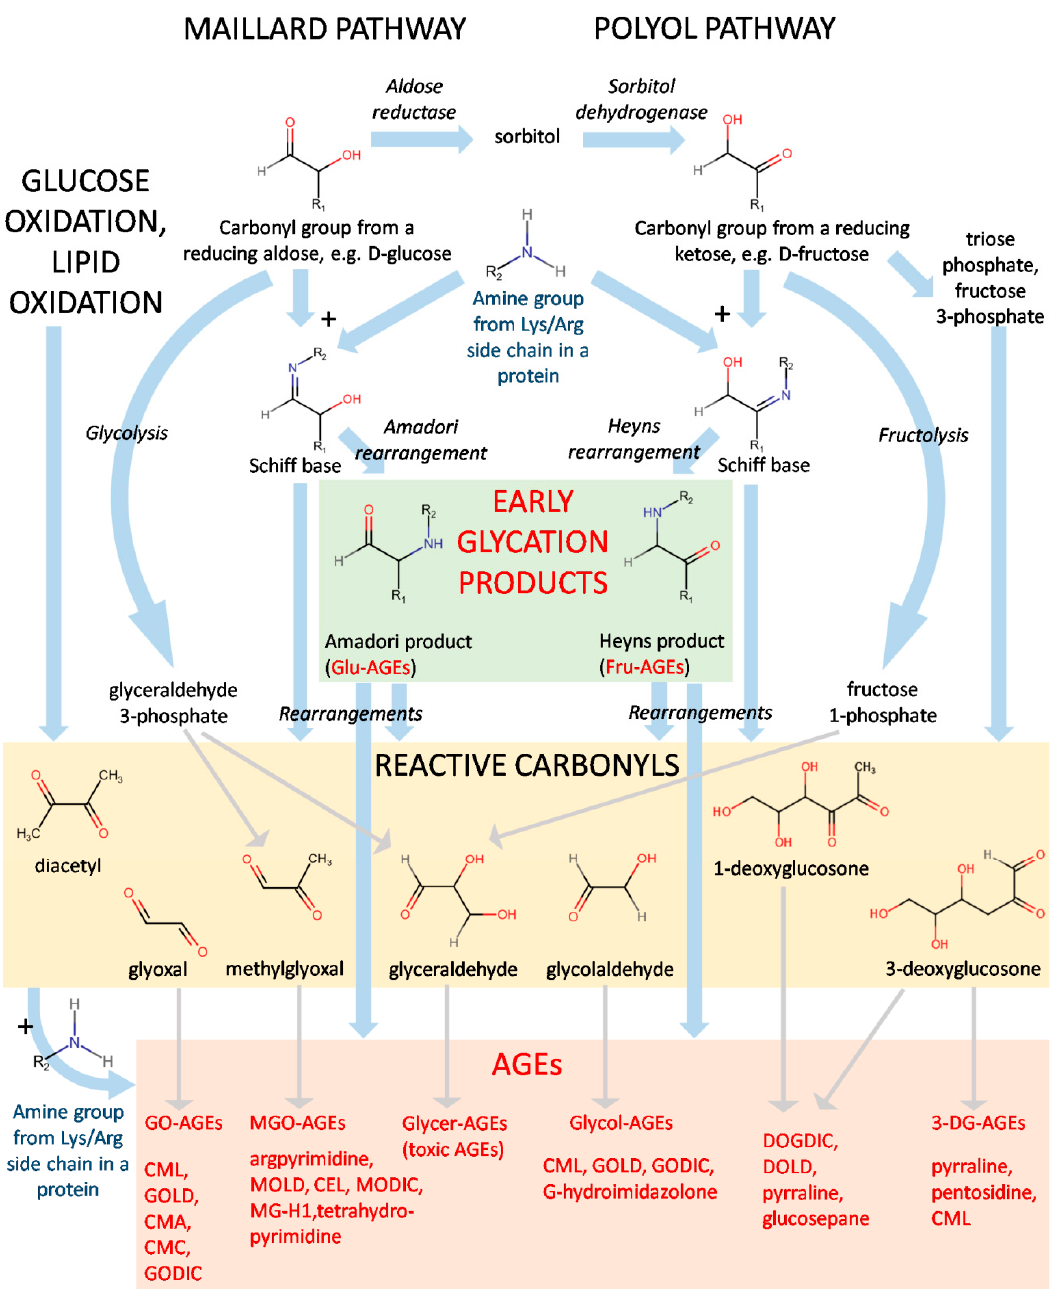
Figure 1. A scheme of formation for AGEs. Abbreviations: glucose ‐ derived (Glu ‐ AGEs), fructose ‐ derived (Fru ‐ AGEs), glyoxal ‐ derived (GO ‐ AGEs), methylglyoxal ‐ derived (MGO ‐ AGEs), glyceraldehyde ‐ derived (Glycer ‐ AGEs), glycolaldehyde ‐ derived (Glycol ‐ AGEs), and 3 ‐ deoxyglucosone ‐ derived (3 ‐ DG ‐ AGEs).